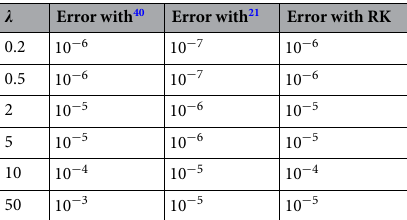
Table 4. Validation of the numerical outcomes of Chebyshev wavelets method with already existing results 21,40 when M